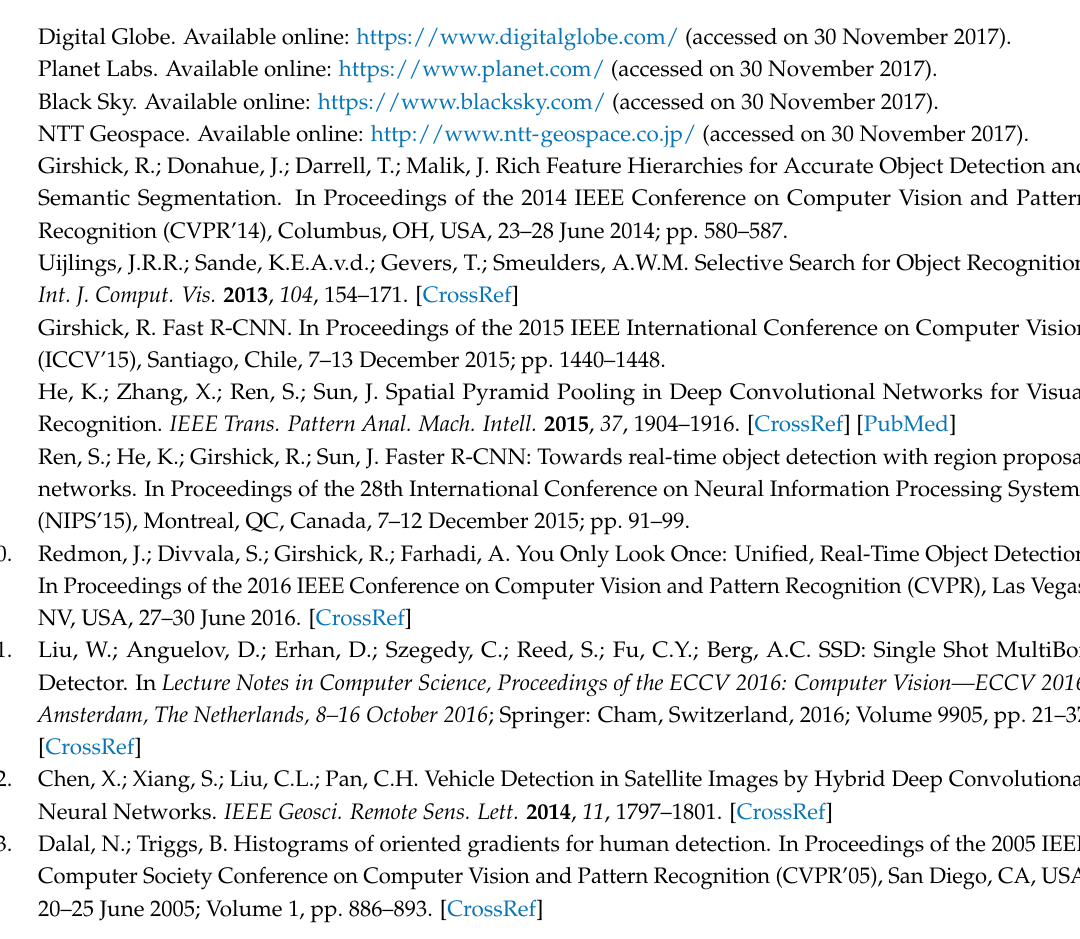
Figure A2. Visualizations of FP patches. ( a ) FP patches in test_1 image; ( b ) FP patches in test_2 image.